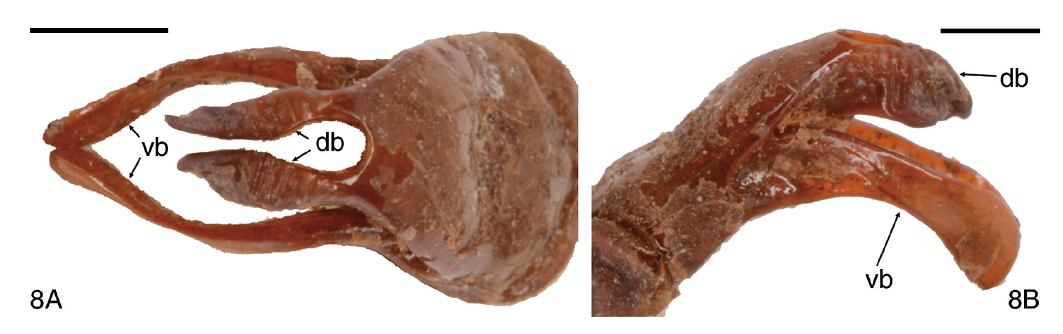
Fig. 8. Morphotype III “ Leucophthalma ”. Male genitalia of M. leucophthalma (Wiedemann, 1819) (non-type, MFNB). Parameres in dorsal (A) and lateral (B) views. Scale bars = 1.0 mm.